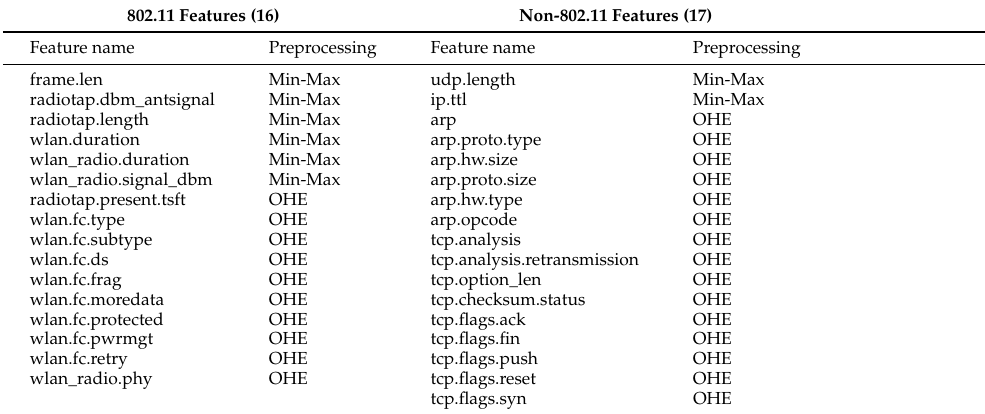
Table 2. The selected sets of features. The 802.11 features were selected from [8]. The rightmost columns per subtable name the normalization step per feature followed during data